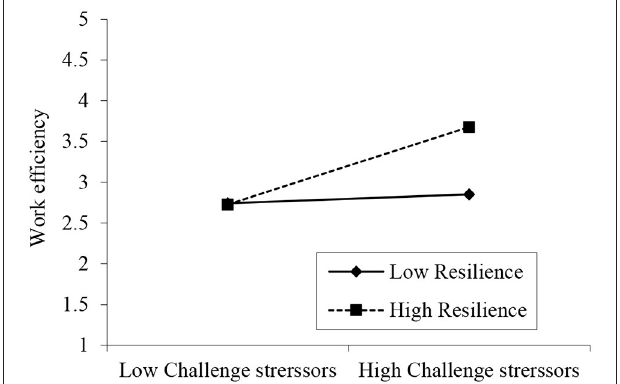
FIGURE 2 | Moderating effect of Resilience in the relationship between Challenge Stressors and Work